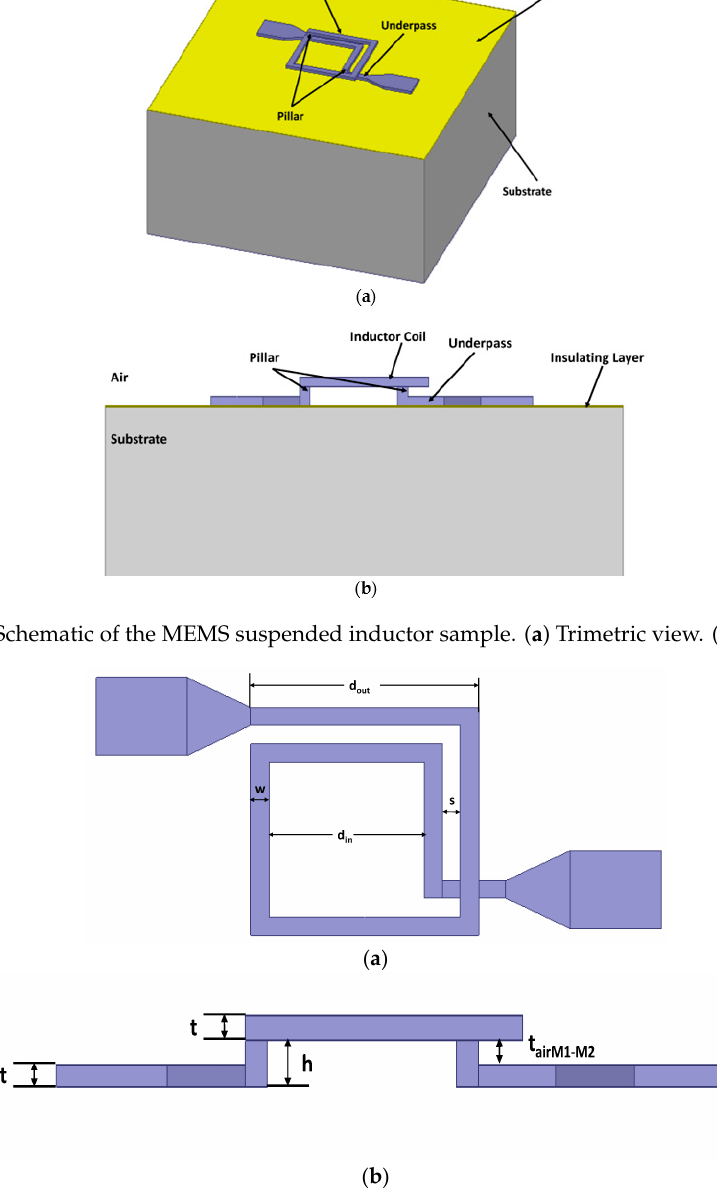
Figure 5. Geometric parameters of the MEMS suspended inductor coil. ( a ) The top view of the inductor coil. ( b ) The side view of the inductor coil.